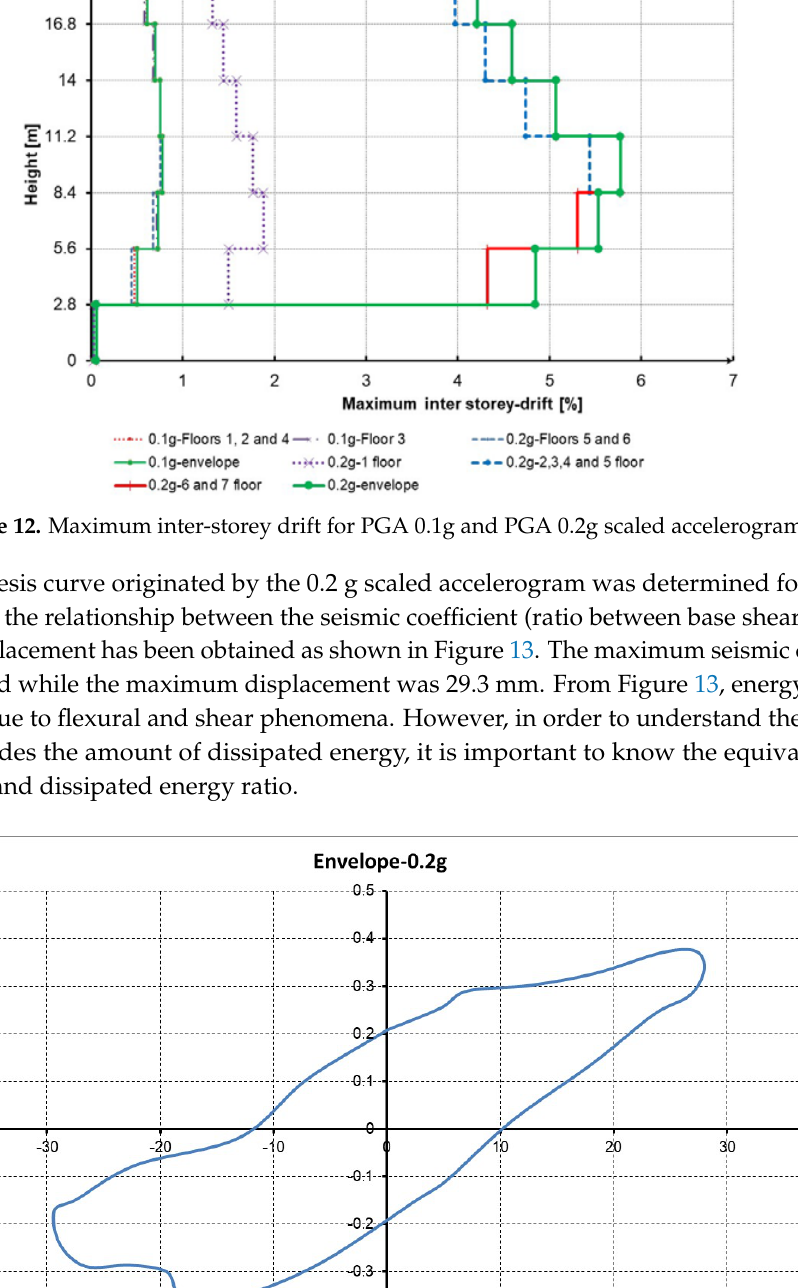
Figure 14. Façade walls damage of the original structure after exposure to PGA = 0.1 g. 4. Strengthening Intervention (EFM Model) The proposed strengthening method followed here is a combination of traditional and modern strengthening techniques. This envisaged solution includes the construction of four new walls (Figure 15a) and strengthening the ground floor with fiber reinforced polymers (FRP) where concentration of damage was observed, see Figure 14. In this way, the structure moved from inadequate to the adequate positioning of the structural walls in plan [32]. The walls were positioned in such a way as to keep the symmetry of the structure and in that way circumvent possible undesirable torsional effects. The new walls are made of solid clay bricks connected with lime mortar in order to be compatible with the existing walls. The four new structural walls were built in place of existing separation walls in order to not affect the serviceability of the structure, besides being the